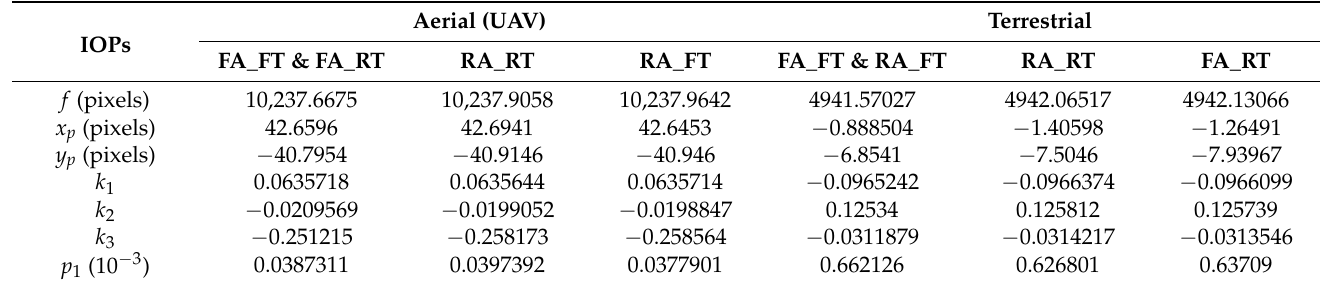
Table 8. IOPs of aerial (UAV) and terrestrial images after the BA of the SWJTU-LIB dataset using different SC strategies.